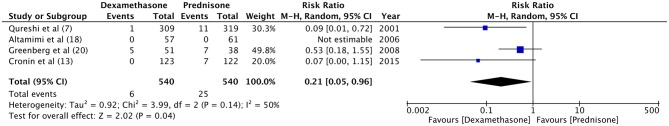
Forrest plot for dexamethasone vs. prednisone for vomiting in Emergency Department.